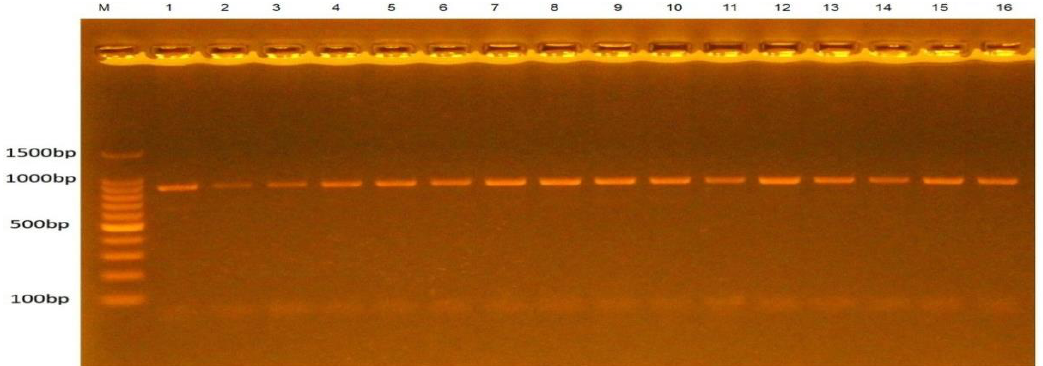
Figure 1. Electrophoresis pattern of PCR product of exon II of MTNR1 A gene with 856 bp size in local goats. Lane M:DNA molecular marker 100 bp size. Ethidium Bromide stained bands in the 1% agarose gel